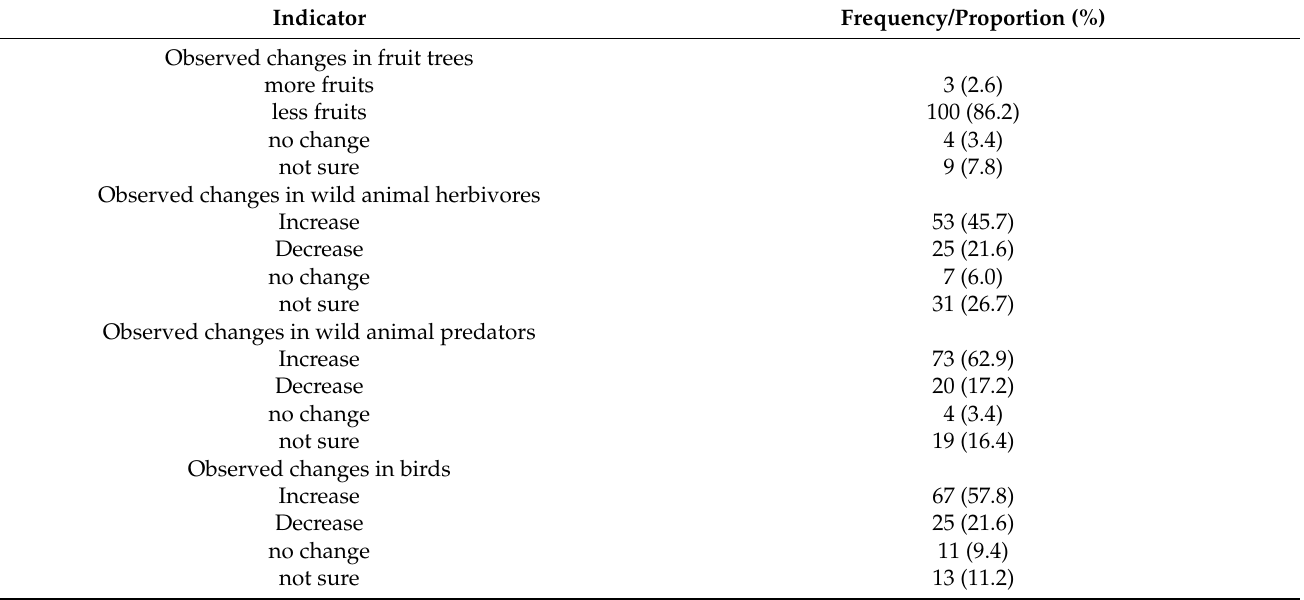
Table 4. Observed changes in the ecological system in Malipati,